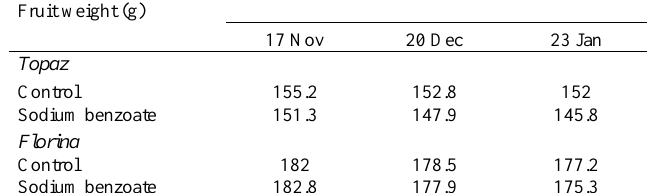
Table 1. Fruit weight (g) of ’Topaz’ and ’Florina’ in control and sodium benzoate treatments assessed at 17 November, 2019,